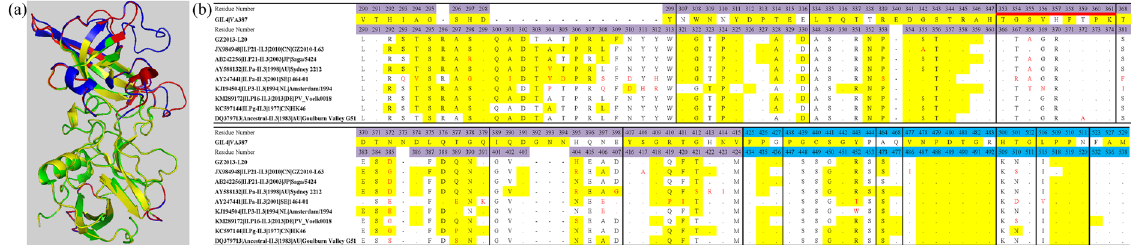
Figure 6. Homology modeling and prediction of potential spatial epitopes of the GII.3 capsid P domain. ( a ) Homology modeling of the P domain of GZ2013-L20. The structural superposition of the predicted structure for GZ2013-L20 P domain (purple) and the crystal structure of GII.4 NoV strain VA387 (green) was performed, which are displayed in cartoon mode. The regions with the major structural differences are highlighted in blue and red for GZ2013-L20 and VA387, respectively. ( b ) Sequence differences between the P domains of representative GII.3 strains and the GII.4 VA387 strain. A black dot indicates the same usage of amino acid as that of the GII.4 strain, and a dash indicates a deletion-mutant. The potential spatial epitopes are highlighted in yellow, and the positions with different amino acids among GII.3 subclusters are colored in red. The predicted epitope region (Epi: 353–361) that is specific to the GII.4 genotype is highlighted with a bold red line below. The sites above the amino acids of the viral capsid protein are highlighted as in Fig.